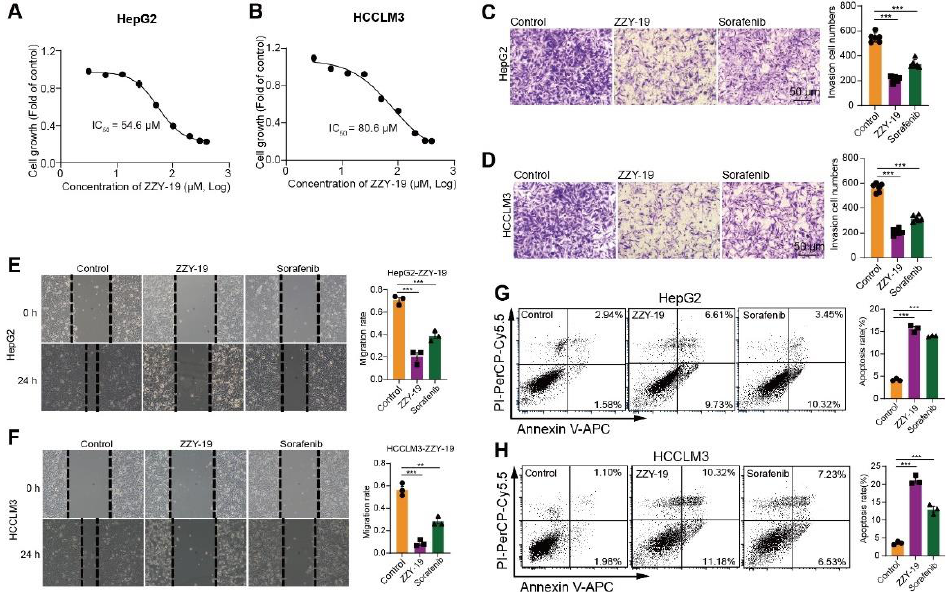
Figure 6. ZZY-19 inhibits the proliferation, invasion, and migration and induces apoptosis of HCC cells. ( A , B ) Effects of ZZY-19 on the proliferation of HepG2 and HCCLM3 cells. The data showed a summary of the IC 50 values for ZZY-19 on HepG2 or HCCLM3 cells. ( C , D ) Representative invasion images and quantification of HepG2 and HCCLM3 cells. HepG2 and HCCLM3 cells were treated with ZZY- 19 (10 μM), Sorafenib (10 μM). Scale bar, 50 μm. ( E , F ) Representative migration images and quantification of HepG2 and HCCLM3 cells. HepG2 and HCCLM3 cells were treated with ZZY- 19 (10 μM), Sorafenib (10 μM). Scale bar, 50 μm. ( G , H ) Representative flow cytometry images of Annexin V-PI staining and quantification of apoptosis. HepG2 and HCCLM3 cells were treated with ZZY- 19 (10 μM), Sorafenib (10 μM). After treatment for 24 h, apoptotic cells were evaluated via Annexin V-PI staining (left), and the histograms showed statistical results of apoptosis rates (right). ** p < 0.01; *** p < 0.001.